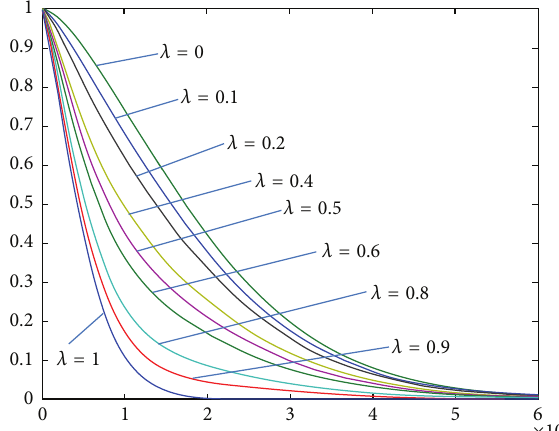
Figure 9: Curve graph about the bogie system reliability with different 𝜆